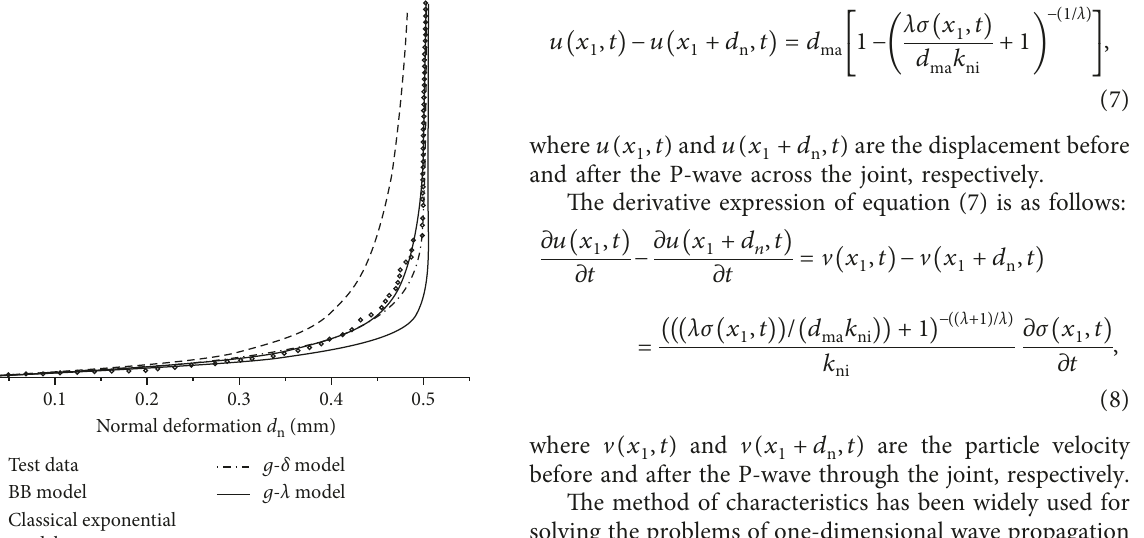
Figure 2: Experiment of a single joint in Arizona granodiorite [25] under compression and simulation [27].